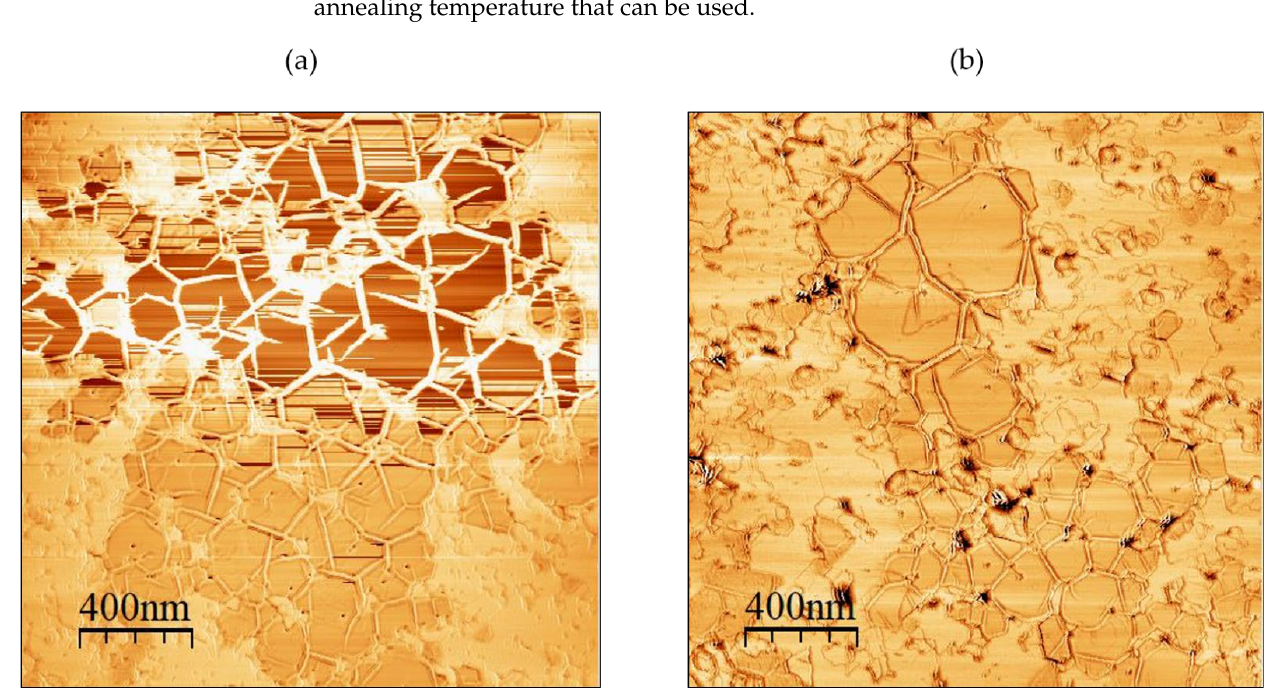
Figure 9. Atomic force microscopy phase images of (2 × 2) µm 2 showing h-BN regions resulting from the diffusion of h-BN through the AlN up to the surface for ( a ) sample A (50 nm AlN) and ( b ) sample B (100 nm AlN).